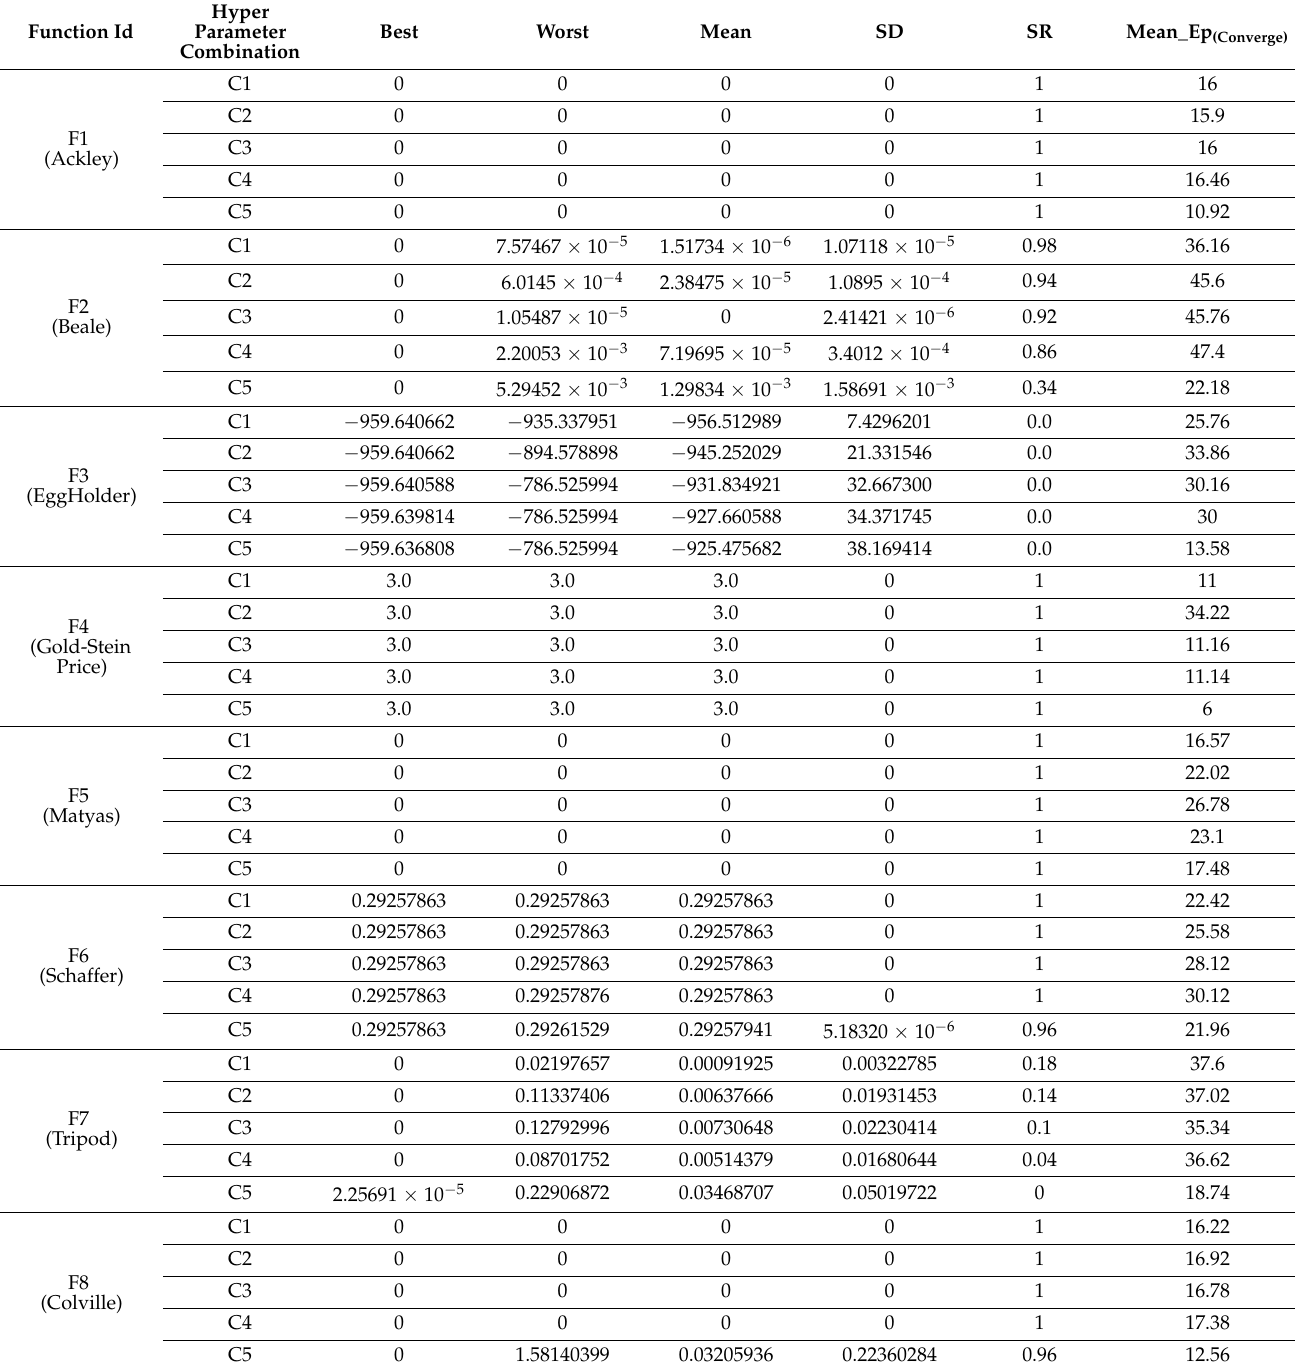
Table 4. Results of numerical experiments performed on the selected benchmark functions for various hyperparameter combinations of